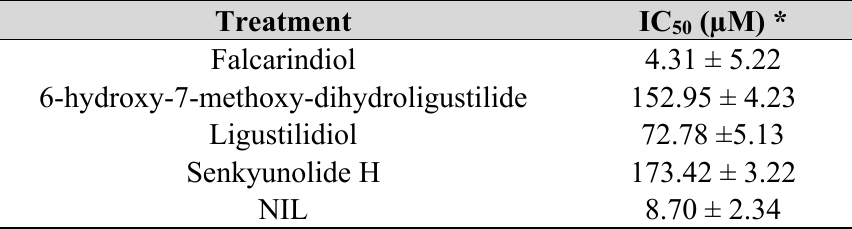
Table 2. IC values of compounds for LPS-induced NO production. 50